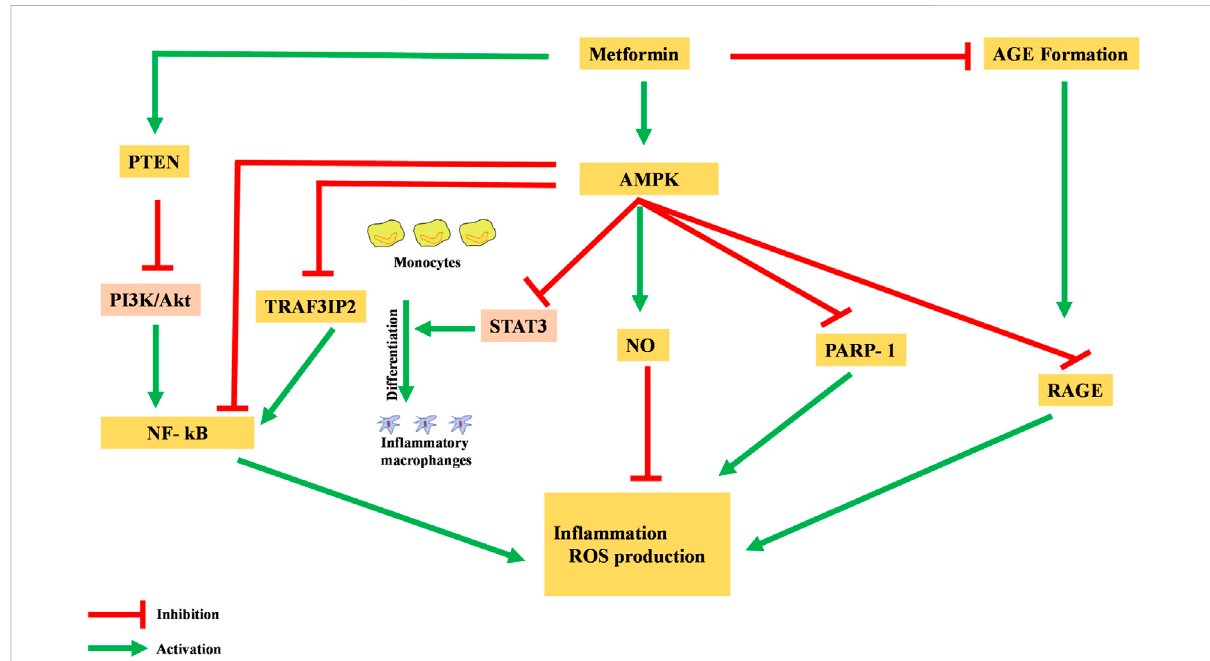
FIGURE 3 Anti-in fl ammatory action of metformin via different pathways. NF- κ B, nuclear factor kappa-light-chain-enhancer of activated B cells; AGE, advanced glycation end products; ROS, reactive oxidative